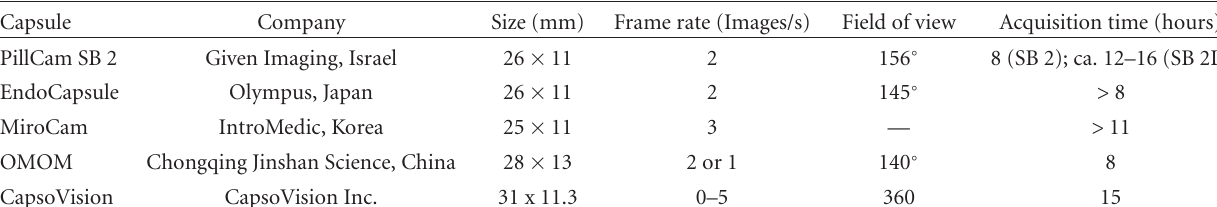
Table 1: Four capsule endoscopes are available at present.